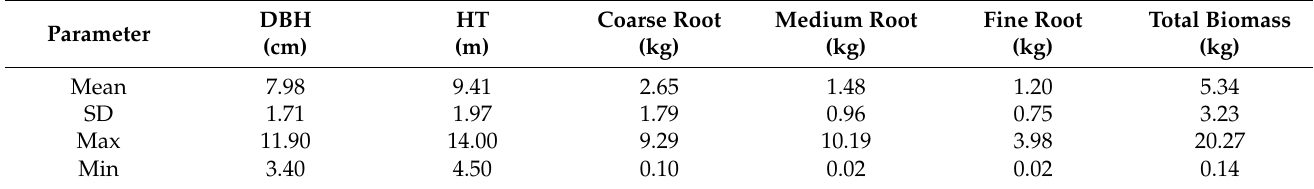
Table 2. Summary statistics of diameter at breast height (DBH), tree height (HT), and root biomass for the sampled trees ( n =